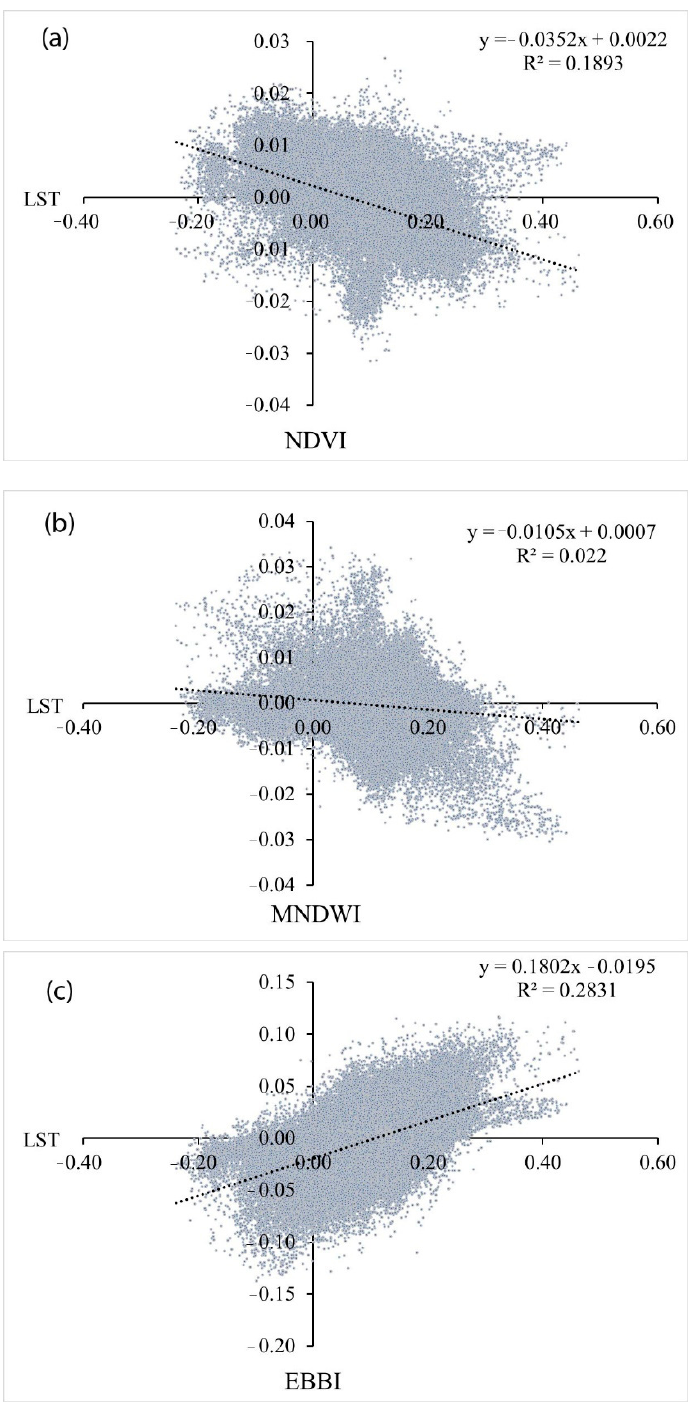
Figure 11. Scatter plot of the annual rate of change in the LST and the annual rate of change in the NDVI ( a ), MNDWI ( b ) and EBBI ( c ) indices in the study area (1987–2019).